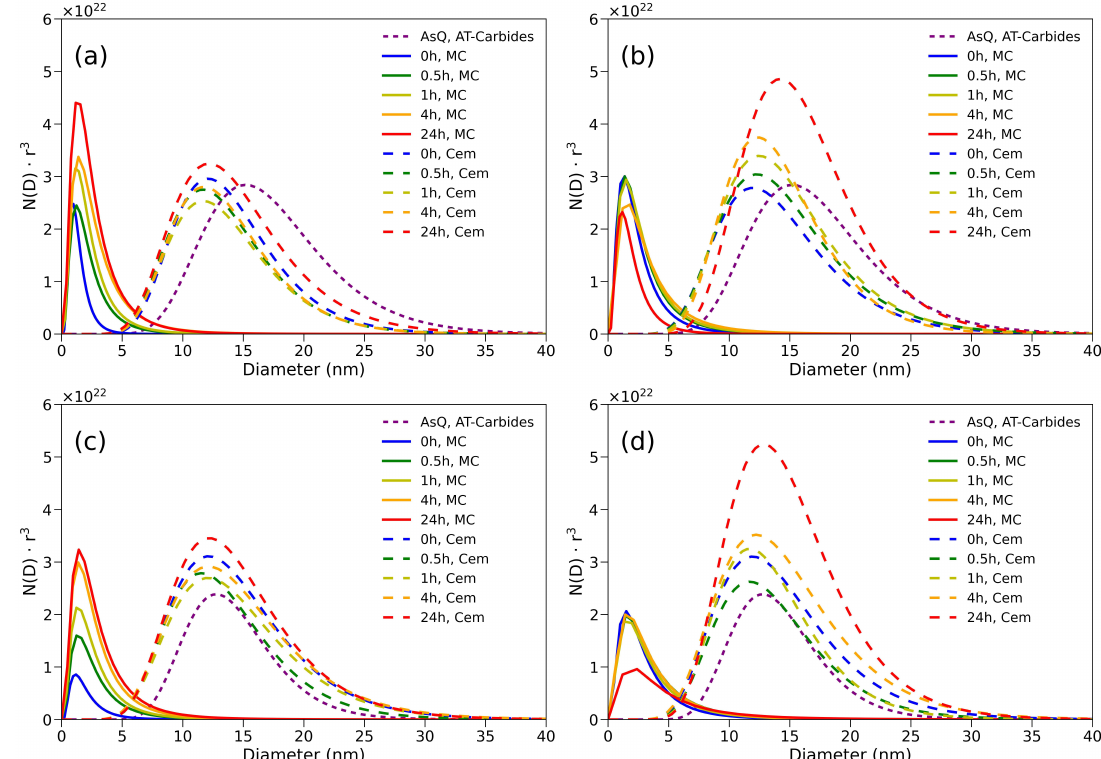
Figure 8Figure 9. Particle volume normalized size distributions. ( a ) Material A 550 ◦ C, ( b ) Material A 600 ◦ C, ( c ) Material B 550 ◦ C, ( d ) Material B 600 ◦